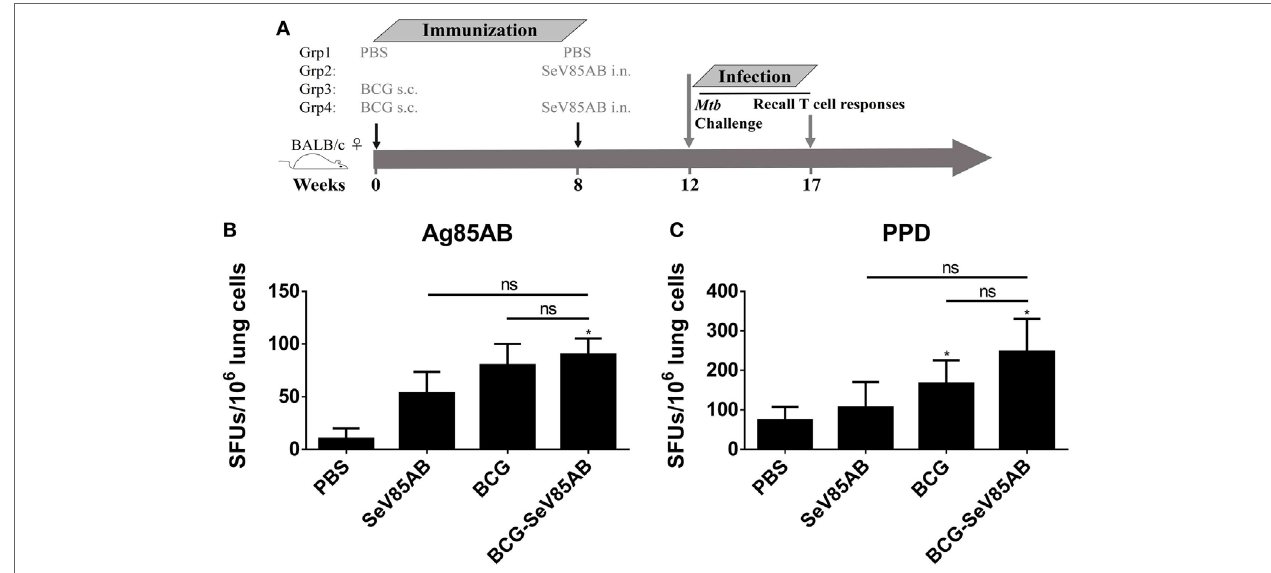
FigUre 6 | Recall T cell responses against specific stimulation post Mycobacterium tuberculosis ( Mtb ) challenge determined by IFN- γ Enzyme Linked Immunospot (ELISPOT) assay. (a) Immunization and infection schedule. Vaccinated mice were aerosol challenged 4 weeks later with virulent Mtb H37Rv. Five weeks postinfection, recall lung T cell responses were determined. (B,c) The IFN- γ responses by ELISPOT assay. Cells from the infected lung were stimulated for 20 h with Ag85AB peptide pool (B) or PPD (c) in 96-well plates, respectively. Significant differences in frequency between T cell subsets are indicated. Data are representative of two independent experiments with three mice per group. ns, no significant